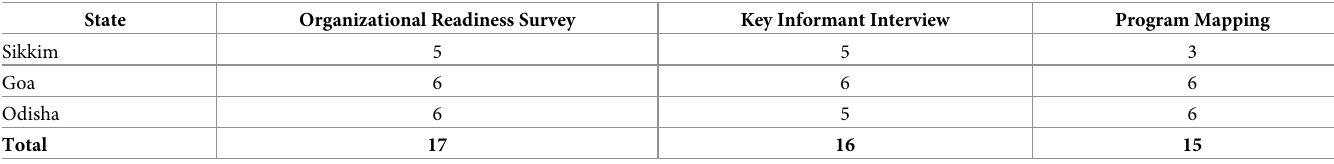
Table 1. Number of study participants from each state. State Organizational Readiness Survey Key Informant Interview Program